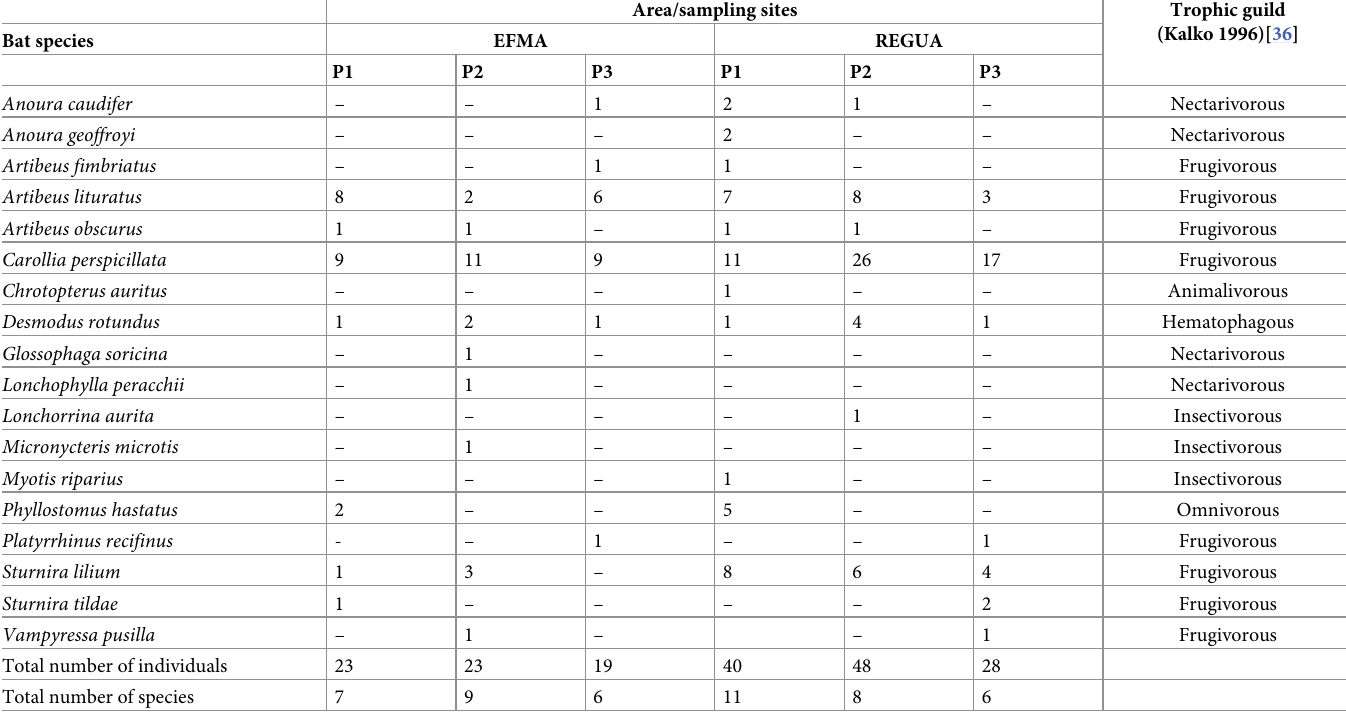
Table 1. Bat species examined at each area (Estac¸ ã o Biolo´gica Fiocruz Mata Atlaˆntica [EFMA] and Reserva Ecolo´gica Guapiac¸u [REGUA]) and sampling site (P1, P2 or